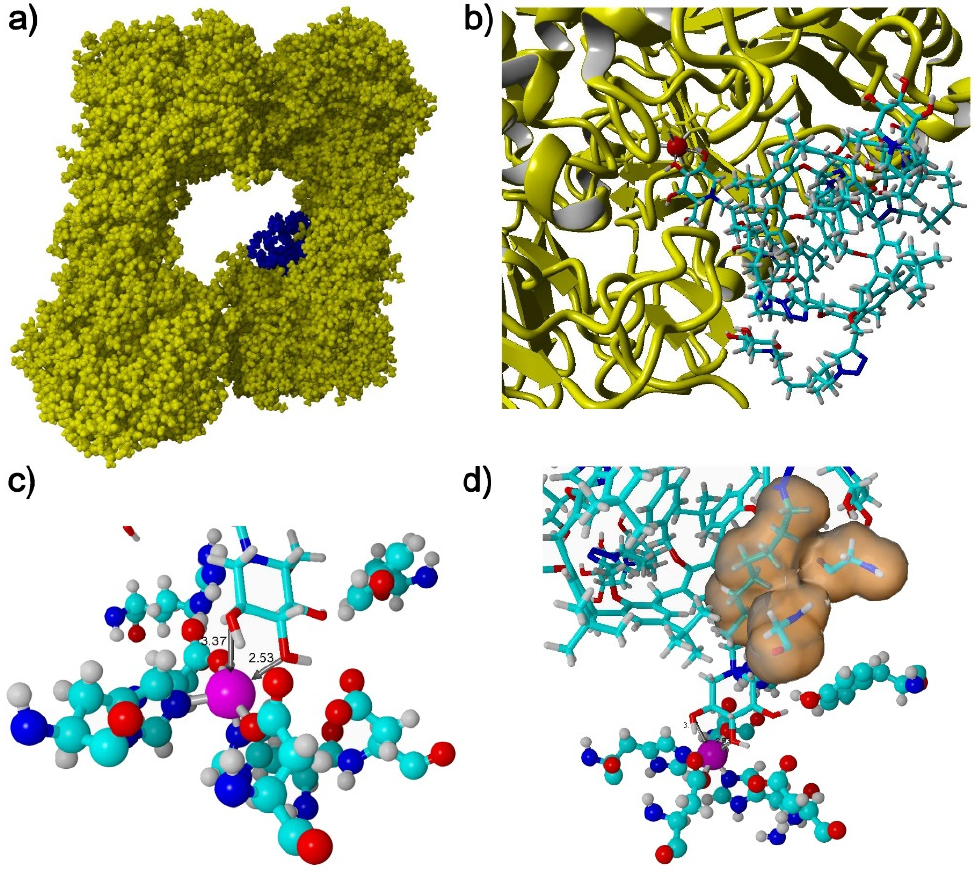
Figure 3. Docking experiments. ( a , b ) The 3D model of the binding mode of 7b with JB α -man. In ( a ) the ligand 7b is given in blue while the protein is colored in yellow. ( b ) Magnification of the interaction with ligand 7b. ( c ) Detailed view of the octahedral coordination of Zn ion (in magenta) in enzyme pocket: the coordination of Zn ion with the oxygen atoms of the iminosugar is highlighted. ( d ) Detailed view of the hydrophobic interactions between the lipophilic alkyl chain of the Zn-coordinated DNJ of cluster 7b with G788 and G790.